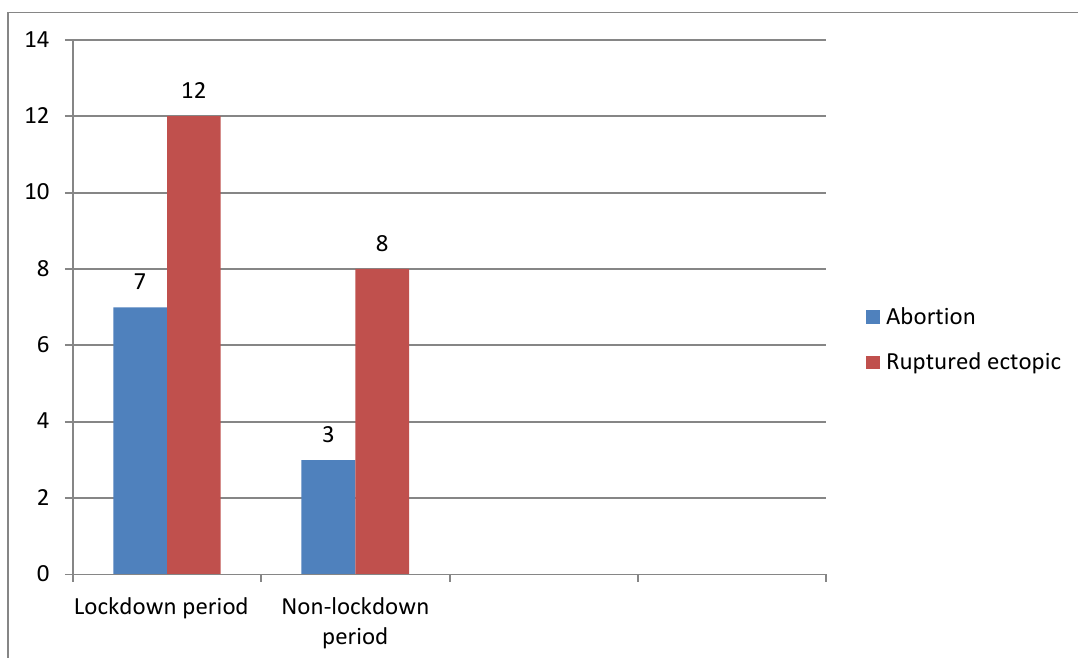
Figure 1. Early pregnancy complications in the lockdown and the non-lockdown